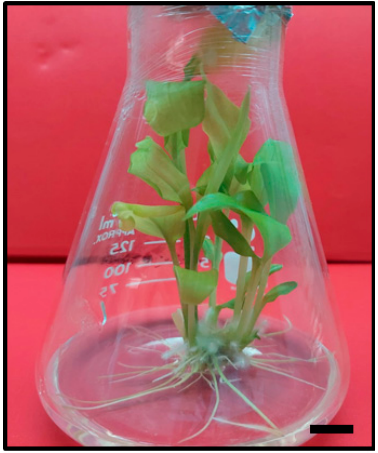
Figure 2. Shoot multiplication of C. caesia in MSB5 medium supplemented with 15 μ M BAP at eight weeks after inoculation. Scale bar represents 1 cm of actual size.